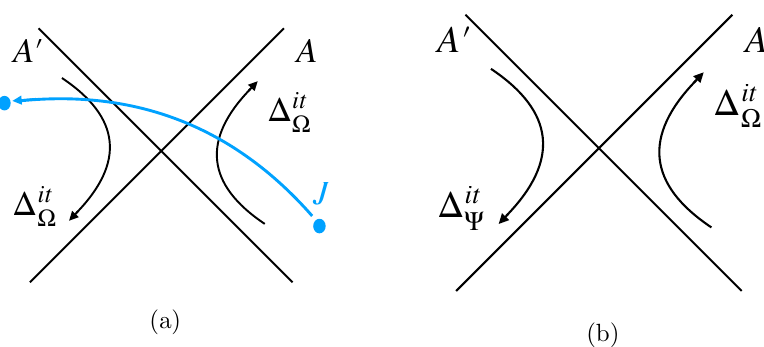
Figure 7. If the region A is the Rindler wedge and the state is a QFT in the vacuum, the modular (cid:13)ow is the boost that evolves operators geometrically according to the arrows in (a) [14]. The modular conjugation map J (cid:10) is the CRT (charge conjugation/re(cid:13)ection/time reversal) that sends operators from A to A 0 and vice versa. (b) The relative modular (cid:13)ow generated by (cid:1) it modular (cid:13)ow of (cid:10) on the operators in A and the modular (cid:13)ow of state (cid:9) on the operators in A 0